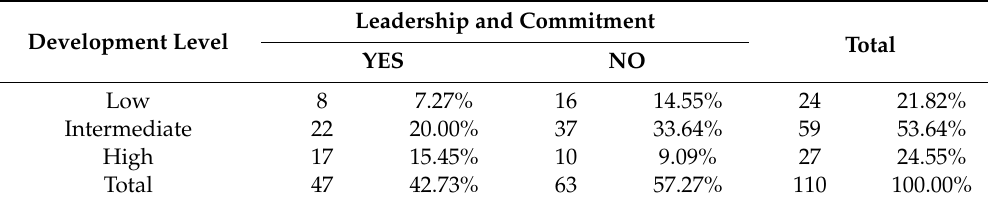
Table 1. Contingency table of absolute and relative (as % of the total) frequencies of performance measurement and management (PMM) system development level and leadership and